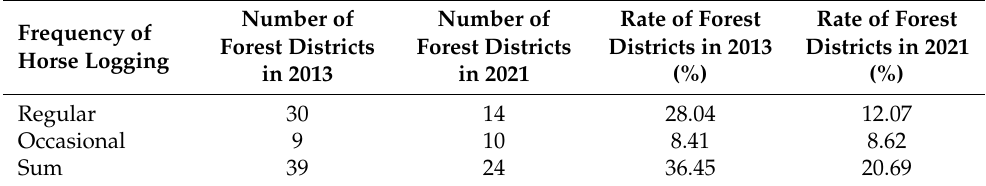
Table 2. Forest districts that applied horse logging in Hungary in 2013 and 2021 (n = 116). Frequency of Horse Logging